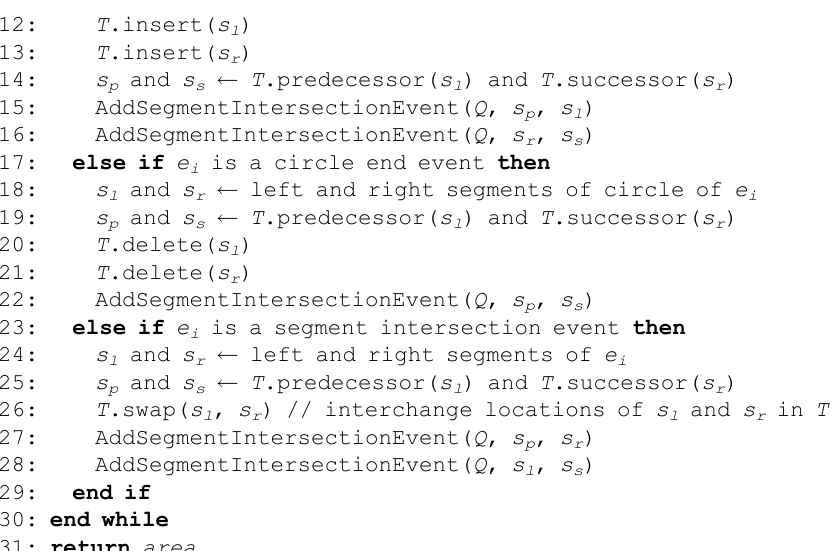
Algorithm 3 describes the procedural steps of adding segment-intersection event points into the event queue Q . The algorithm takes as input the event queue Q and two circle seg- ments s and s . It assumes that the circle segment s a b in the sorted list: s is the predecessor of s a